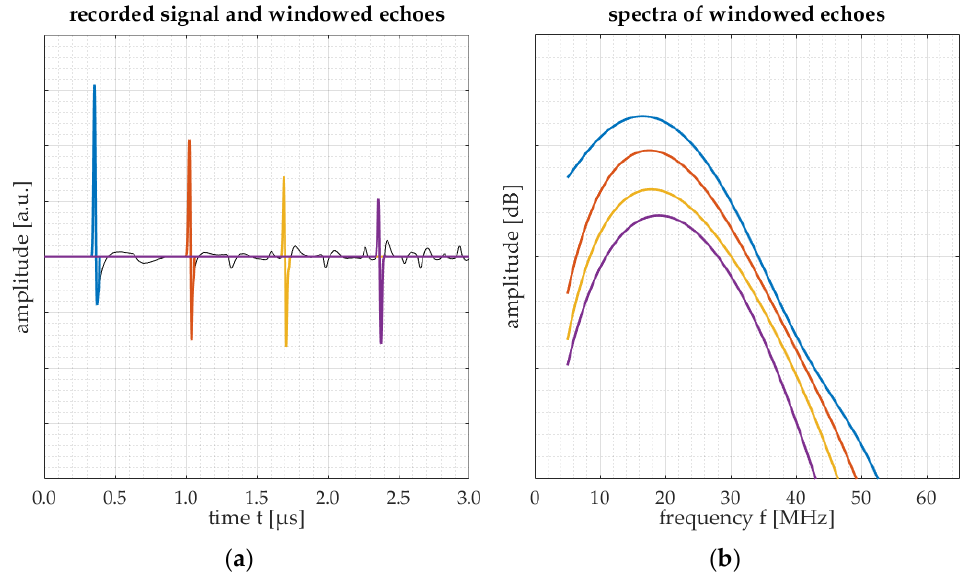
Figure 8. ( a ) The windowed echoes in the time domain; and ( b ) their corresponding spectra in the frequency domain. The four colors correspond in both subplots.